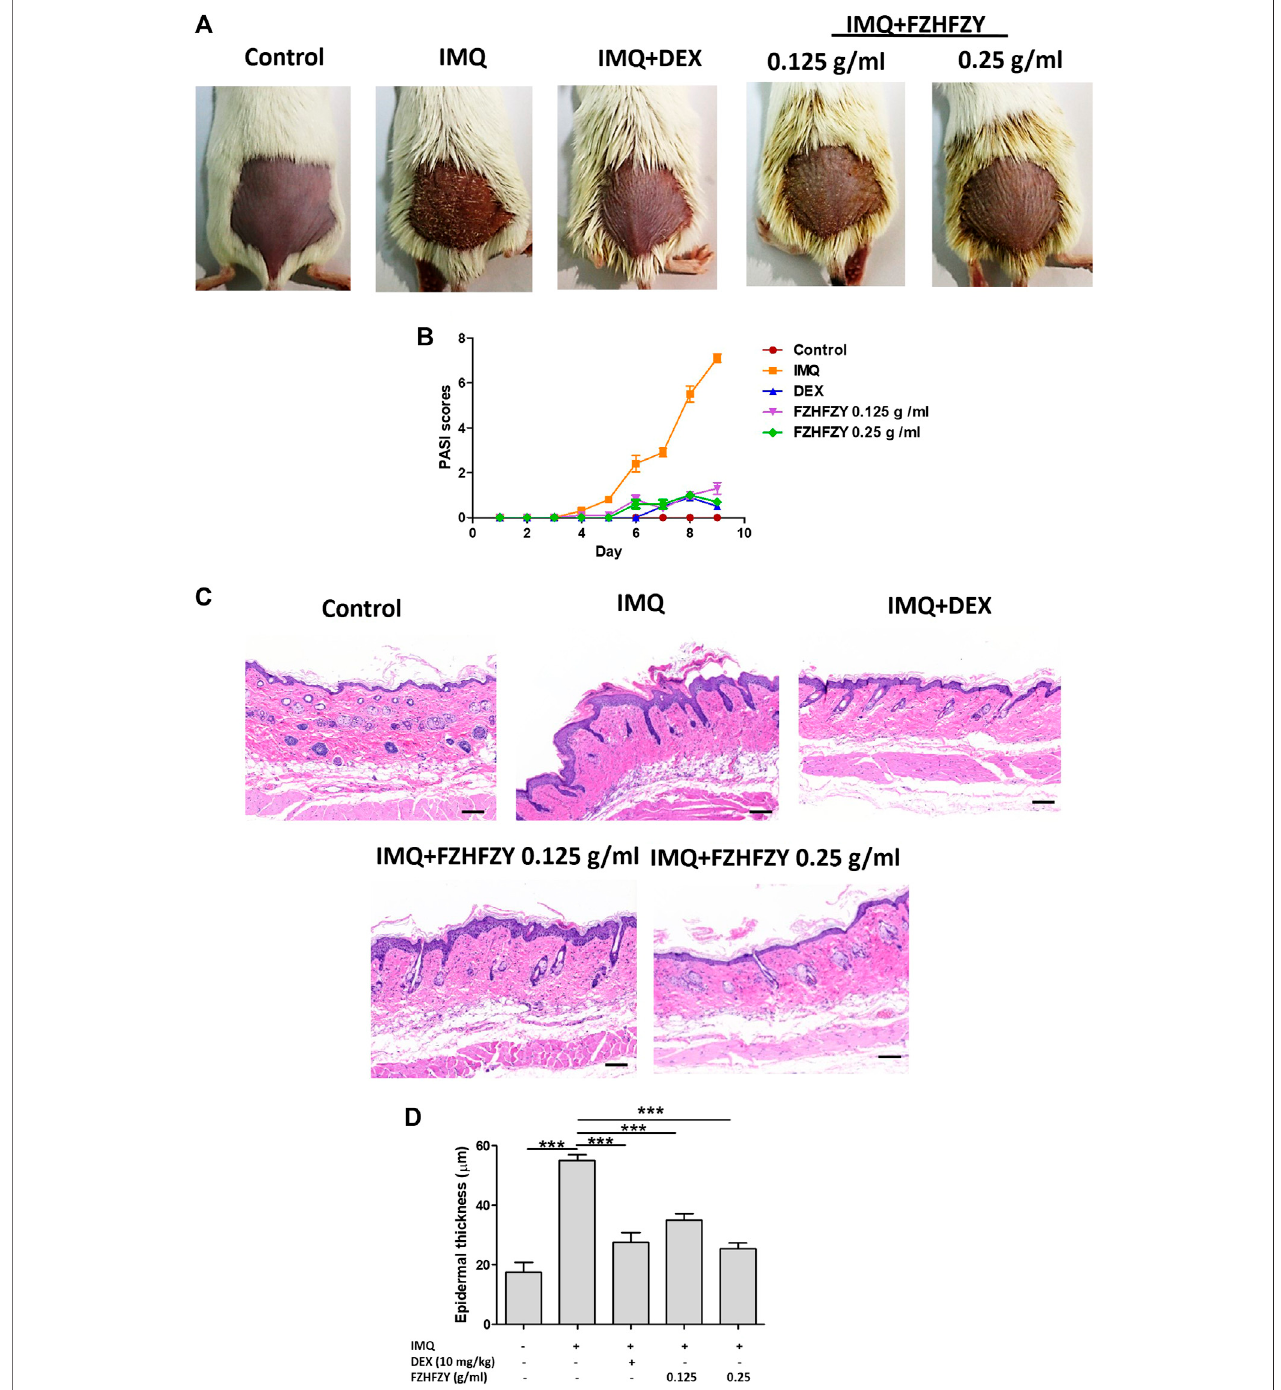
FIGURE 3 | FZHFZY exerts a protective effect against imiquimod (IMQ)-induced psoriasis. (A) Photographs of the backs of mice on day 9 after the fi rst FZHFZY application. All mice were randomly divided into fi ve groups, and dexamethasone (DEX) or FZHFZY administration began 2 days before daily IMQ cream application for 7 days. (B) Severity of psoriasis during the course of IMQ-induced psoriasis, was evaluated by the scores on the psoriasis area and severity index (PASI). (C) Haematoxylinandeosin(H&E)stainingofskintissuefromdifferentgroupsofmice(magni fi cation × 200,scalebar (cid:2) 50 μ m). (D) Epidermalthicknessofmousedorsal skin (*** p < 0.001 vs . IMQ-induced psoriasis group; n (cid:2) 6).